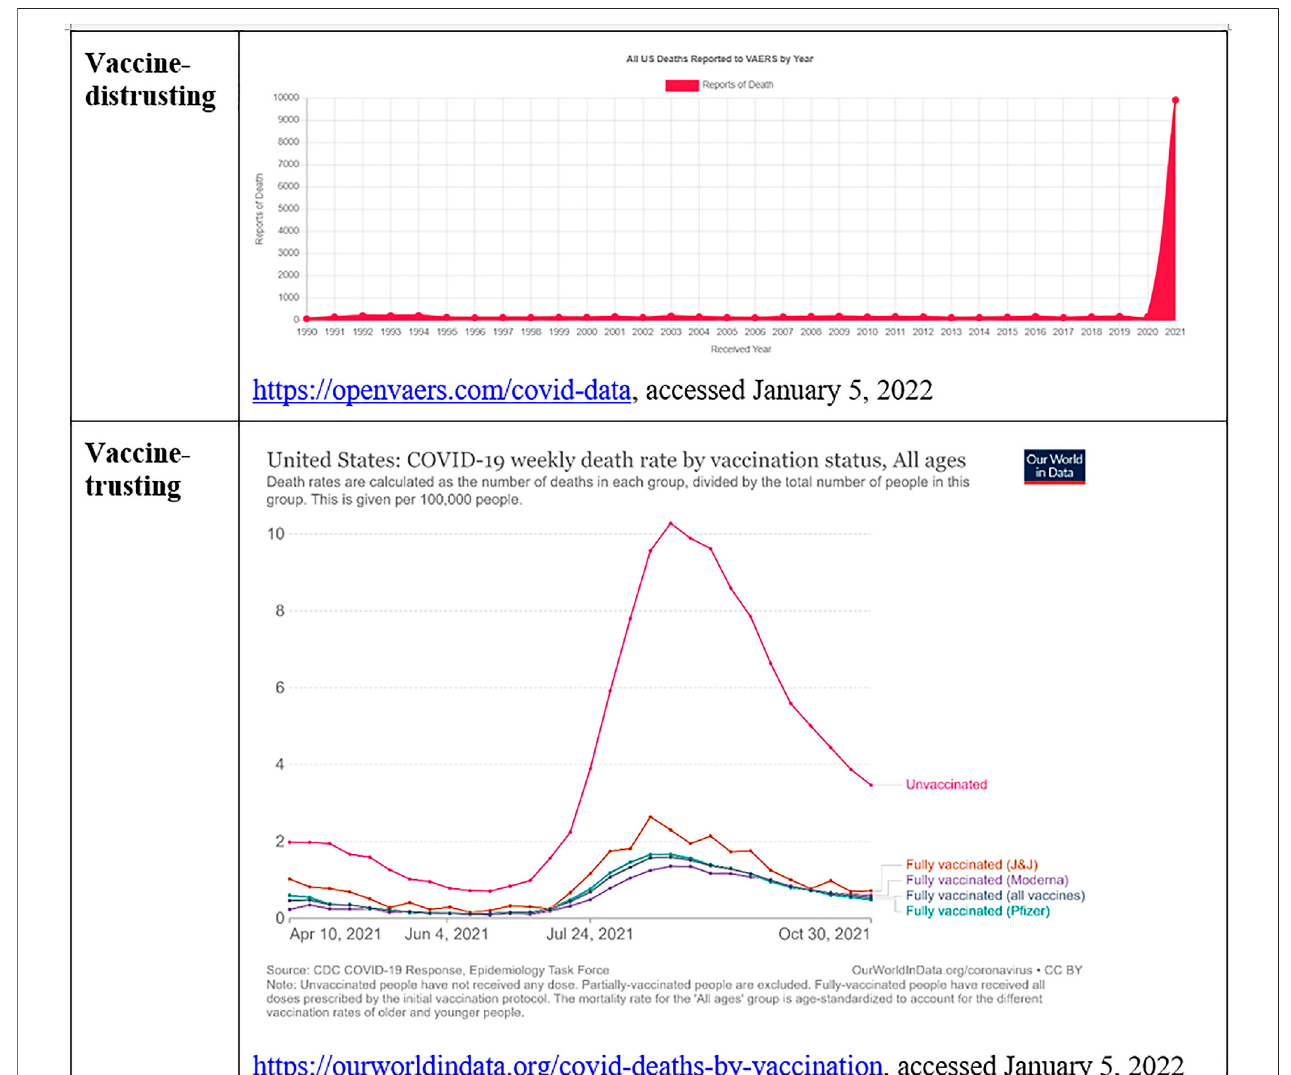
FIGURE 4 | Contrastive interpretation of vaccines through number work as deadly shots (OpenVaers.com) or protection against death (OurWorldInData.org).